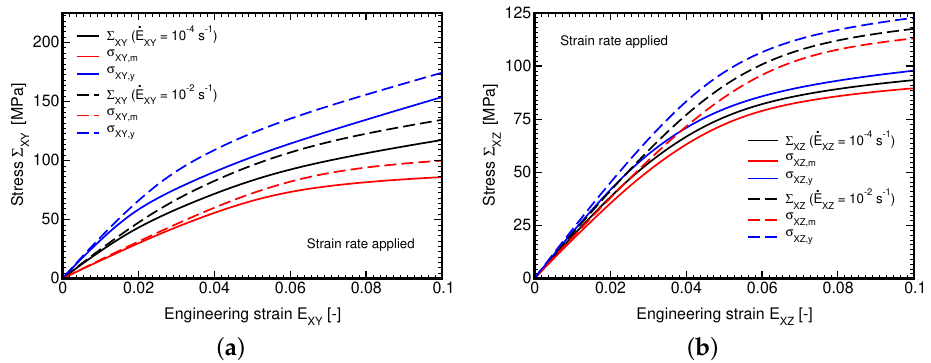
Figure 17. Plain weave composite loaded by prescribed macroscopic in-plane and out-of-plane shear